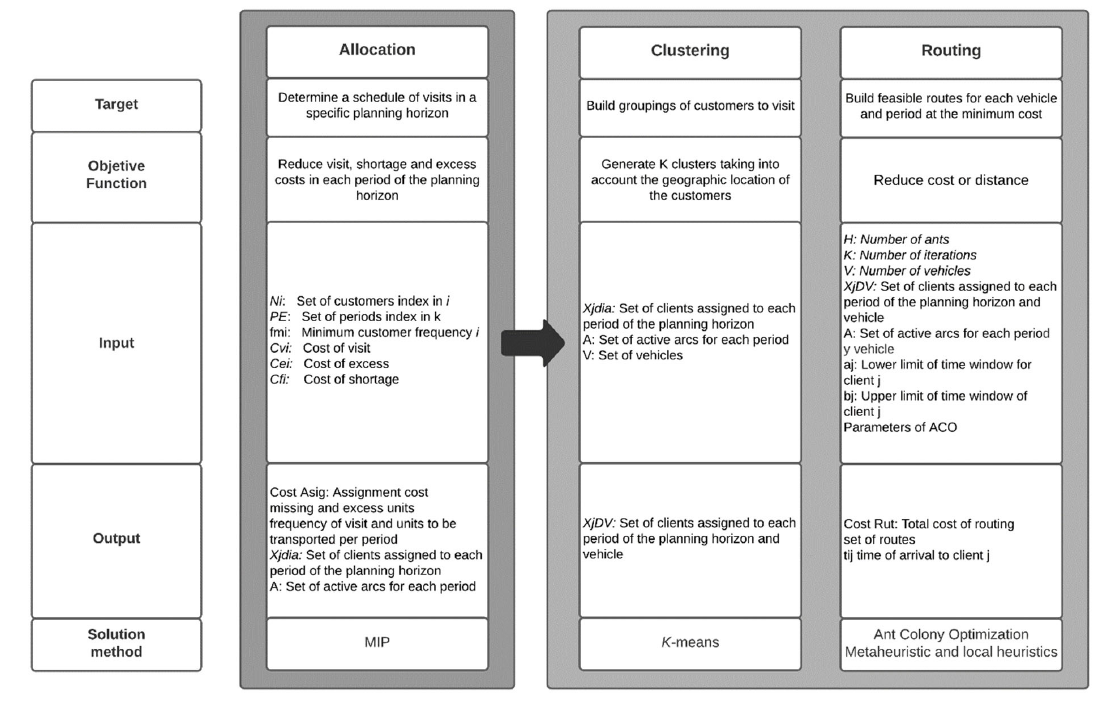
Fig. 1. Proposed solution approach to allocation and